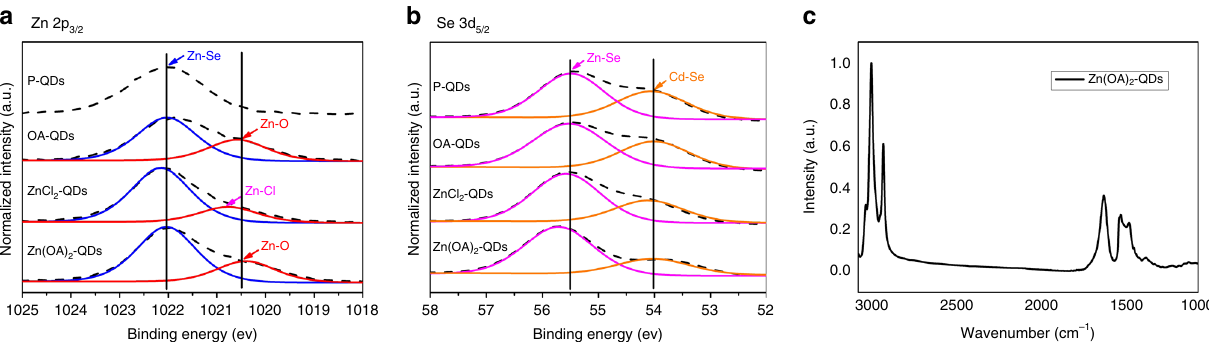
Fig. 3 Characterization of ligand binding states on QD surface. a Zn 2 p 3/2 spectra and b Se 3 d 5/2 spectra from X-ray photo-electronic